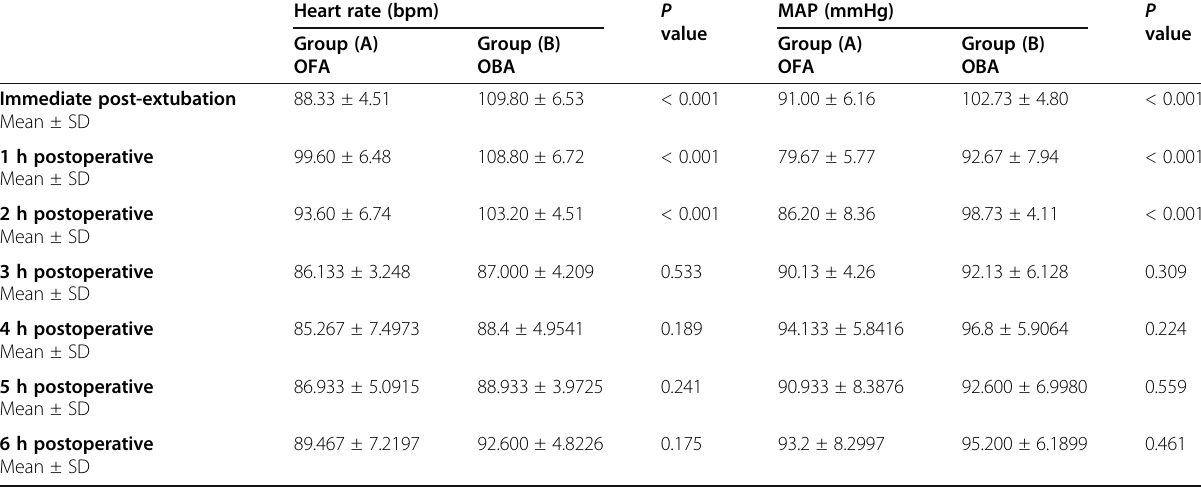
Table 4 Postoperative hemodynamics including heart rate (bpm) and mean arterial blood pressure (mmHg) during the first 6 h